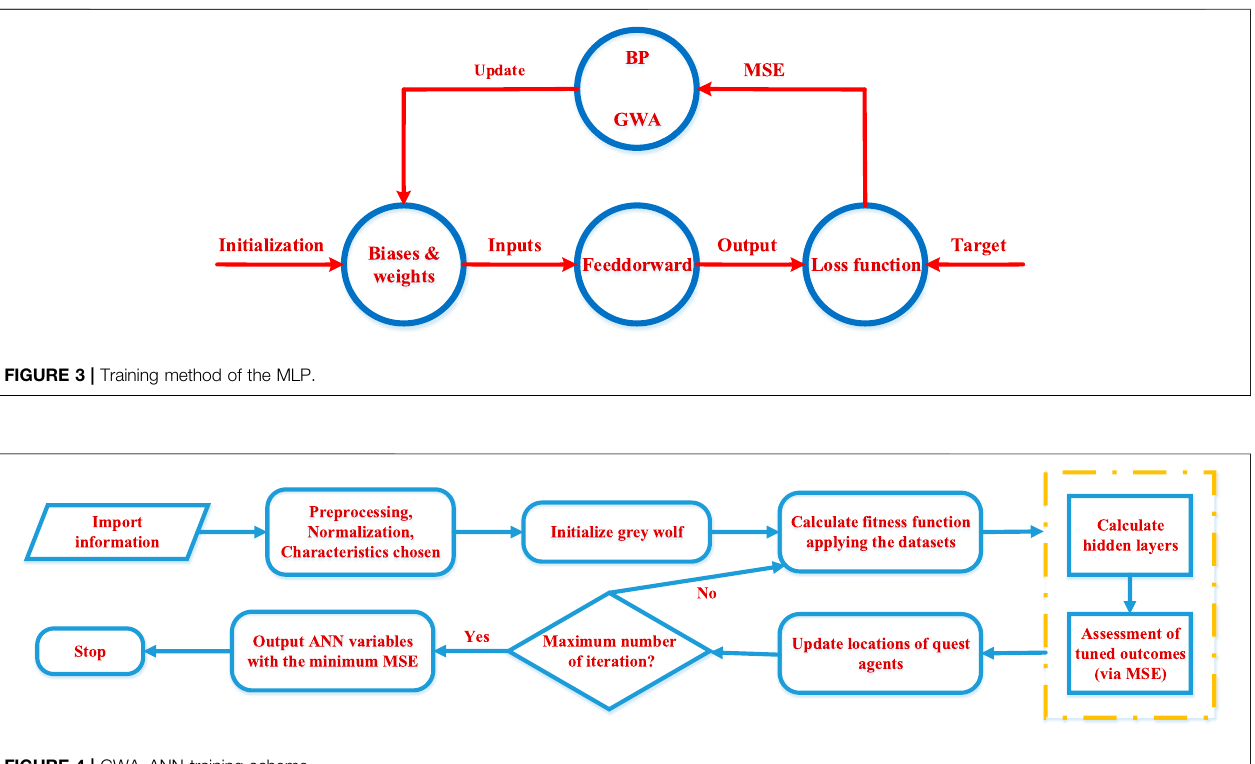
FIGURE 4 | GWA – ANN training